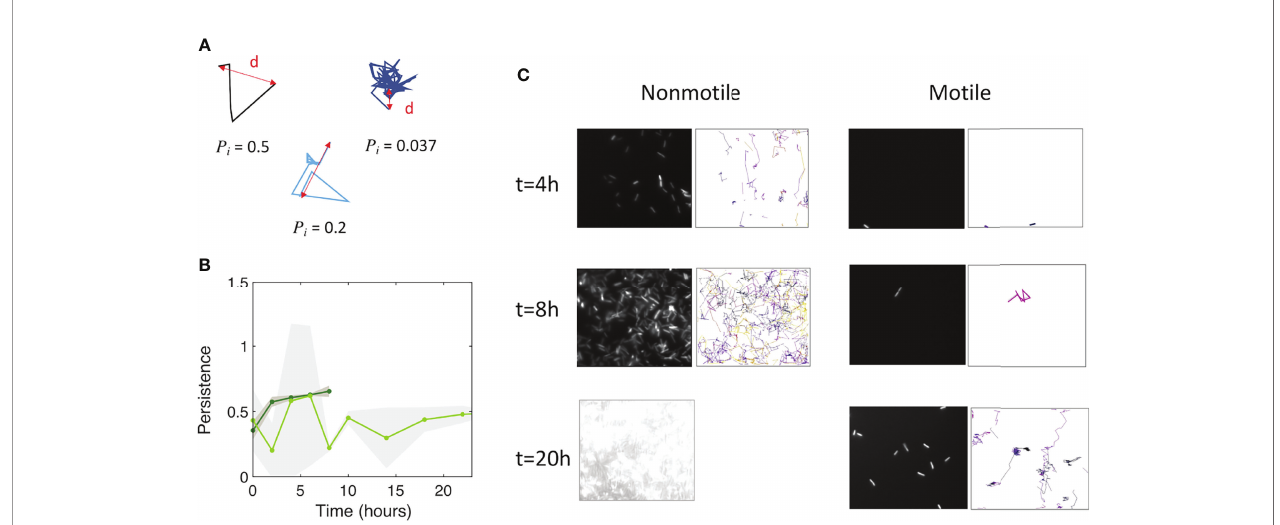
FIGURE 2 | Motile and nonmotile cells display similar surface persistence in the bio fi lm initiation phase. (A) Typical trajectories with their respective persistence index values. (B) Persistence values over time for motile (light green) and nonmotile (dark green) cells on the surface. The curves represent the average, with the shaded area representing the standard deviation. (C) Snapshots of the bio fi lm development together with detected trajectories for nonmotile (left columns) and motile cells (right columns). At t=20h, the surface of nonmotile cells was overcrowded, which excludes the ability to track single cells.